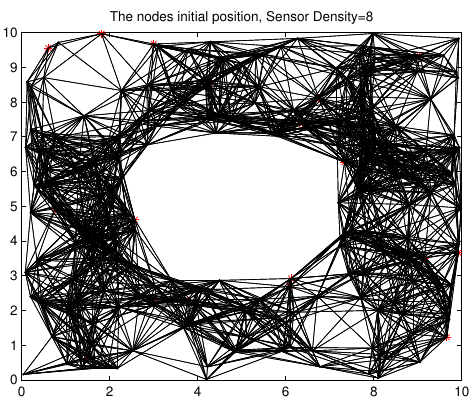
Figure 3. Irregular Topology: O-shape.